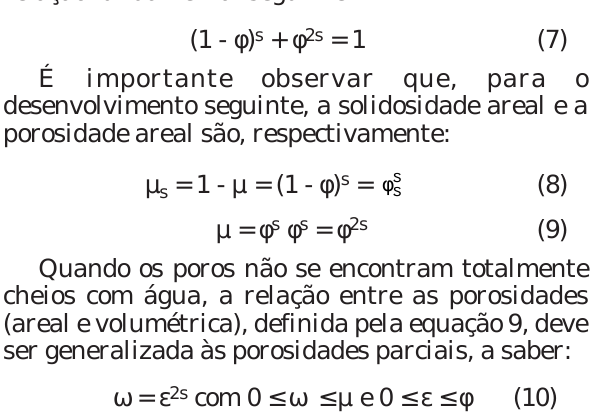
} e { xxxxx , xxxxx s s